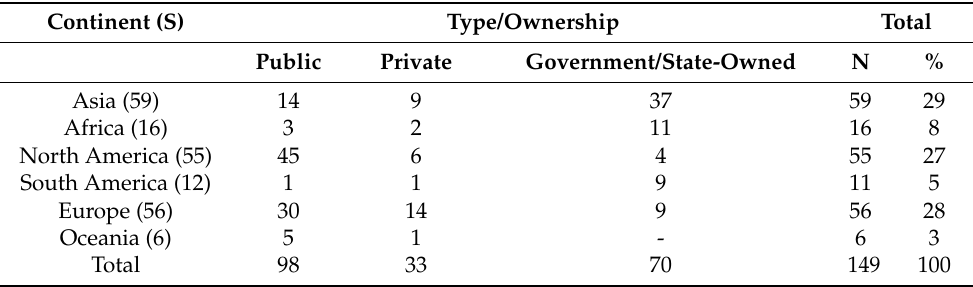
Table 1. Continents and company type/ownership.